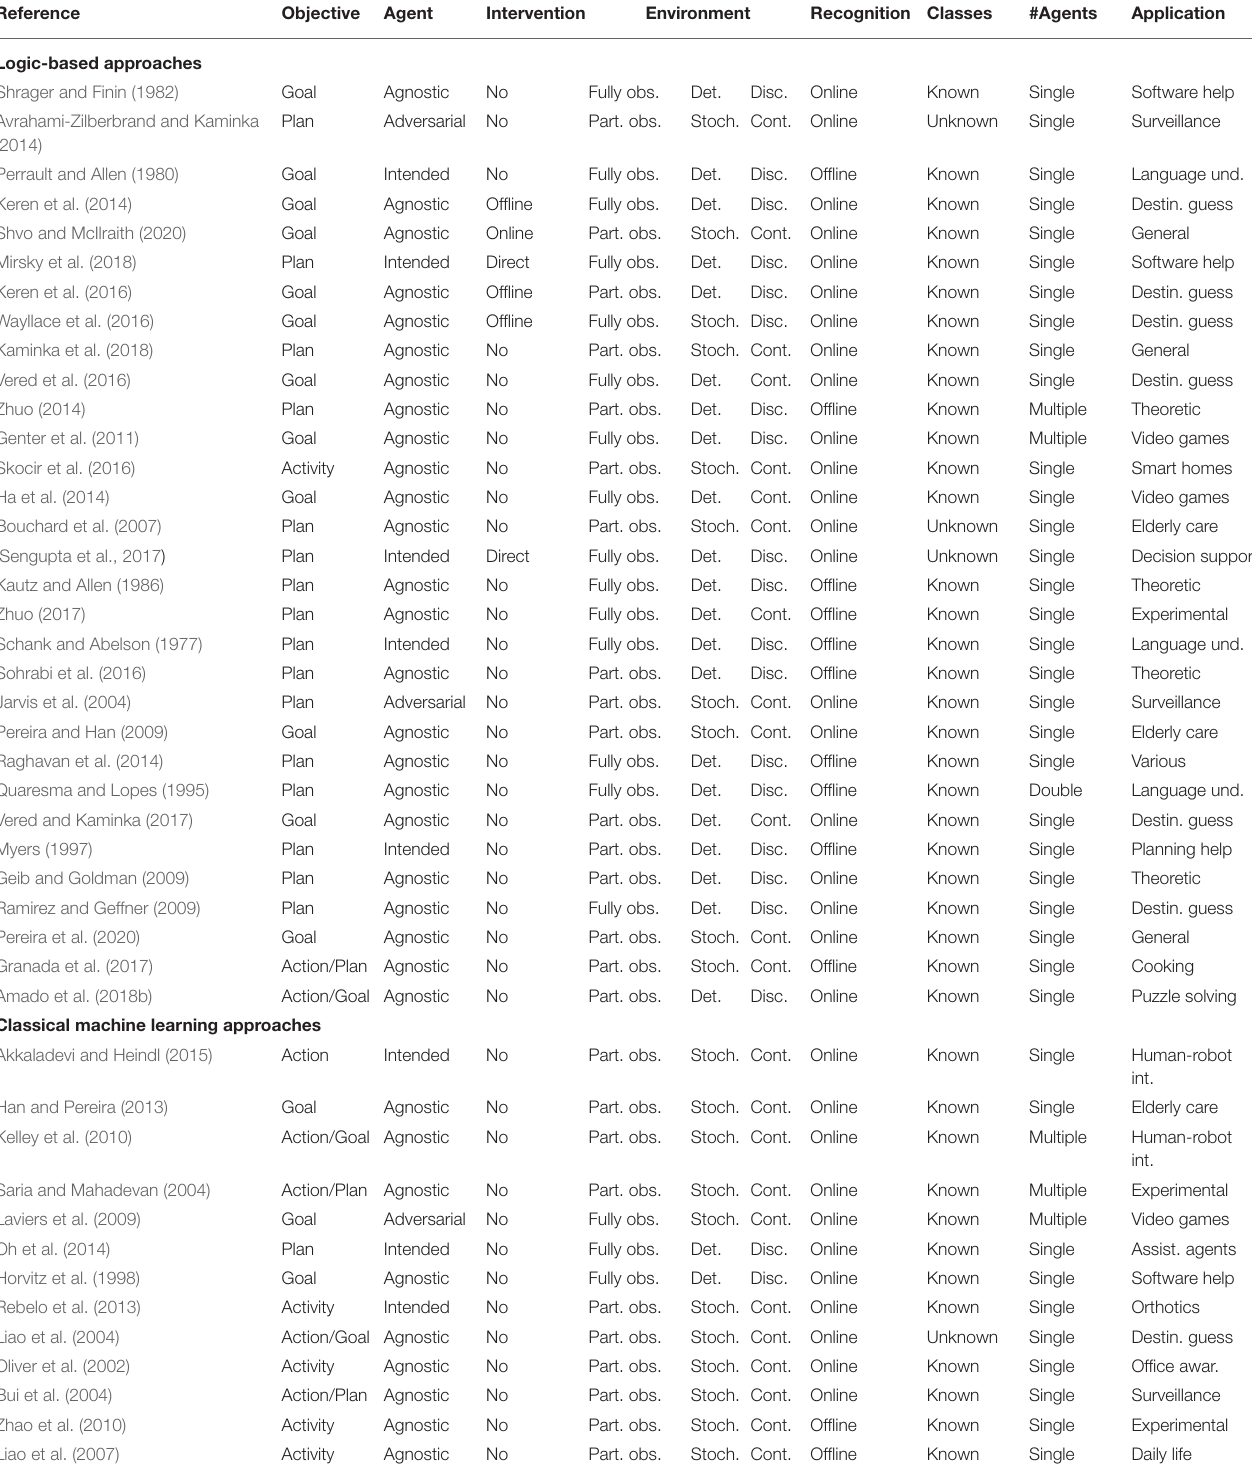
TABLE 1 | Classification of the original studies presented along the review according to their approach (logic-based, classical machine learning, deep learning, or brain-inspired), objective (activity/action, plan, or goal recognition), observed agent involvement (agnostic, adversarial, or intended), observer intervention (no intervention, offline intervention, online intervention, or direct communication), environment (fully or partially observable, deterministic or stochastic, and discrete or continuous), recognition time (offline or online), knowledge of possible classes, i.e., activities/plans/goals (known or unknown), number of agents (single or multiple), and